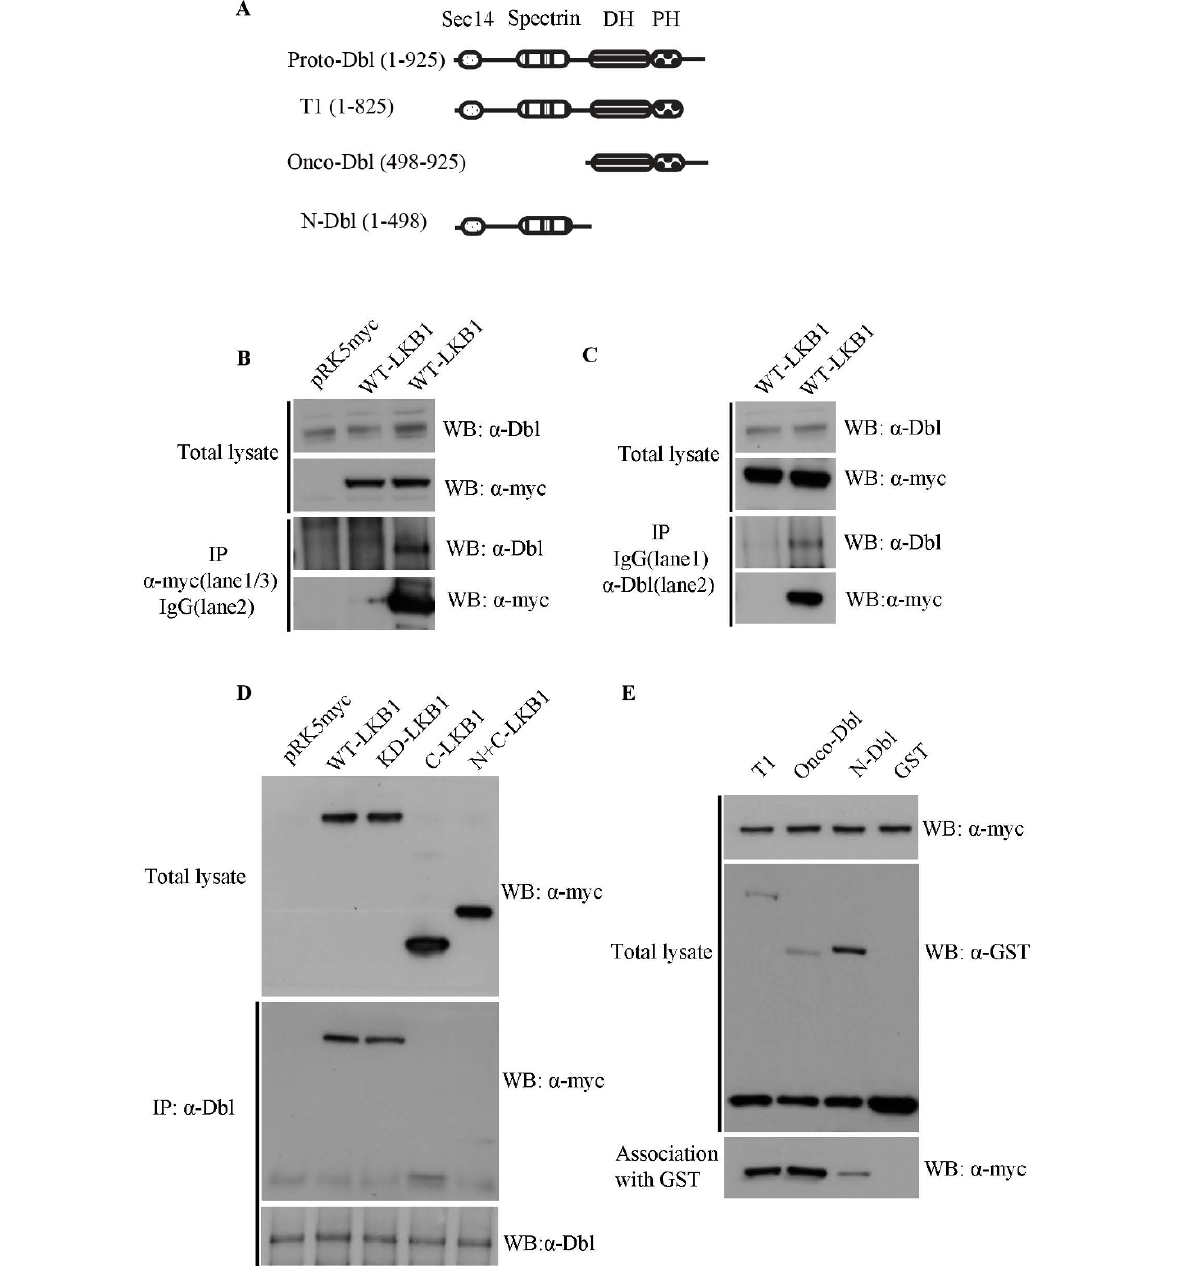
Figure 6 LKB1 interacts with endogenous Dbl . A . Schematic representation of proto-Dbl and the constructs used in this work. B . HeLa-S3 cells transfected with vector (pRK5myc), or pRK5myc-wild type LKB1. LKB1 was immunoprecipitated from cell lysates with anti-myc (lanes 1 and 3), or control IgG (lane 2) antibody and analyzed by western blot analysis. Dbl was detected using a Dbl antibody. Approximately 20% of endogenous Dbl was precipitated with myc antibody. C . HeLa-S3 cells transfected with pRK5myc-LKB1. Cell lysates were subjected to immunoprecipitation using either control rabbit IgG (lane 1), or anti-Dbl antibody (lane 2). Upper two panels are total cell lysates blotted with anti-Dbl and anti-myc antibodies. Lower two panels are Dbl and IgG immunoprecipitates blotted with anti-Dbl and anti-myc antibodies. Around 1% of the overexpressed myc-LKB1 was precipitated with endogenous Dbl using anti-Dbl. D . HeLa-S3 cells transfected with pRK5myc, or pRK5myc with LKB1 cDNAs. Bottom two panels: Endogenous Dbl immunoprecipitated from cells lysates with anti-Dbl antibody, followed by western blot using either an anti-myc, or anti-Dbl antibody. Top panel: Expression of LKB1 in total cell lysates using anti-myc. E . Dbl constructs expressed in HEK293T cells as GST fusion proteins and purified using glutathione agarose. Equal amounts of cell lysate isolated from cells expressing pRK5myc-wild type LKB1 were added to the beads, and bead-associated LKB1 detected on western blot analysis using anti-myc antibody (bottom panel). GST-Dbl and LKB1 were detected with anti-GST and anti-myc antibody,